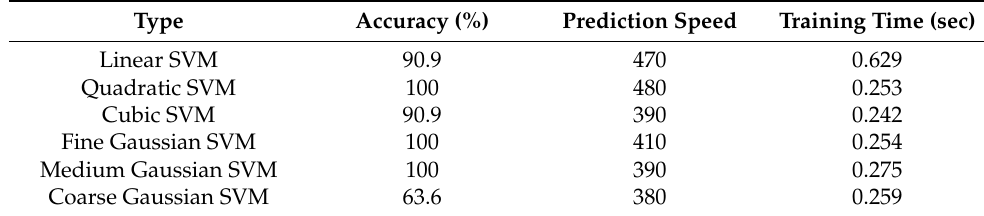
Table 7. SVM 4 DGA classification outcomes.